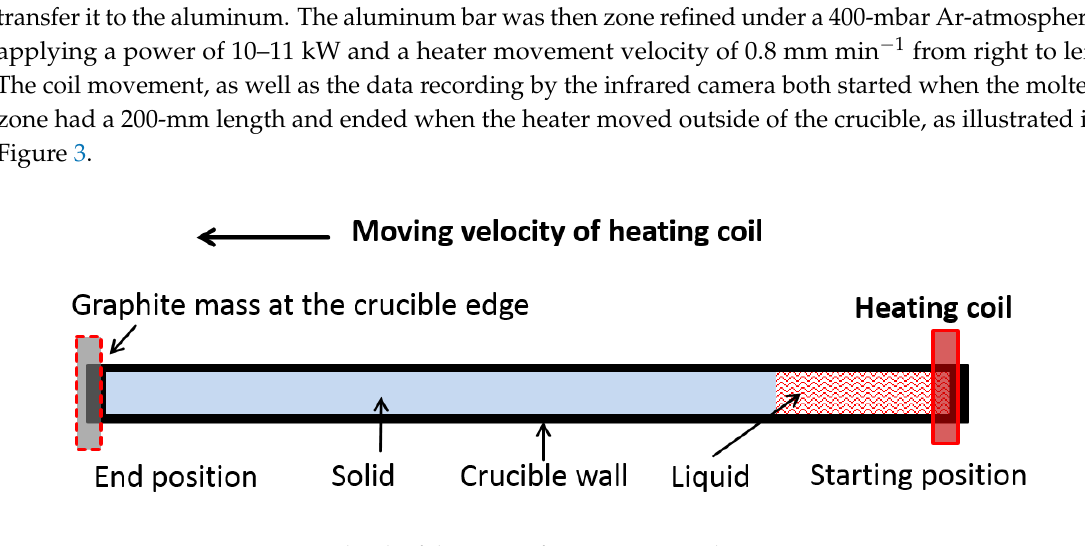
Figure 3. Sketch of the zone refining process in the